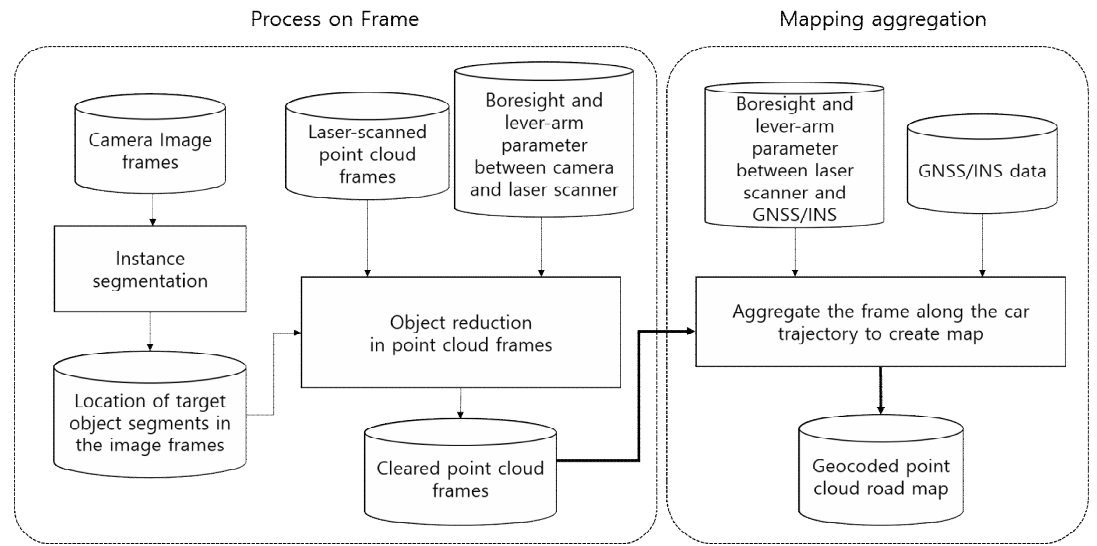
Figure 5. Schematic workflow.